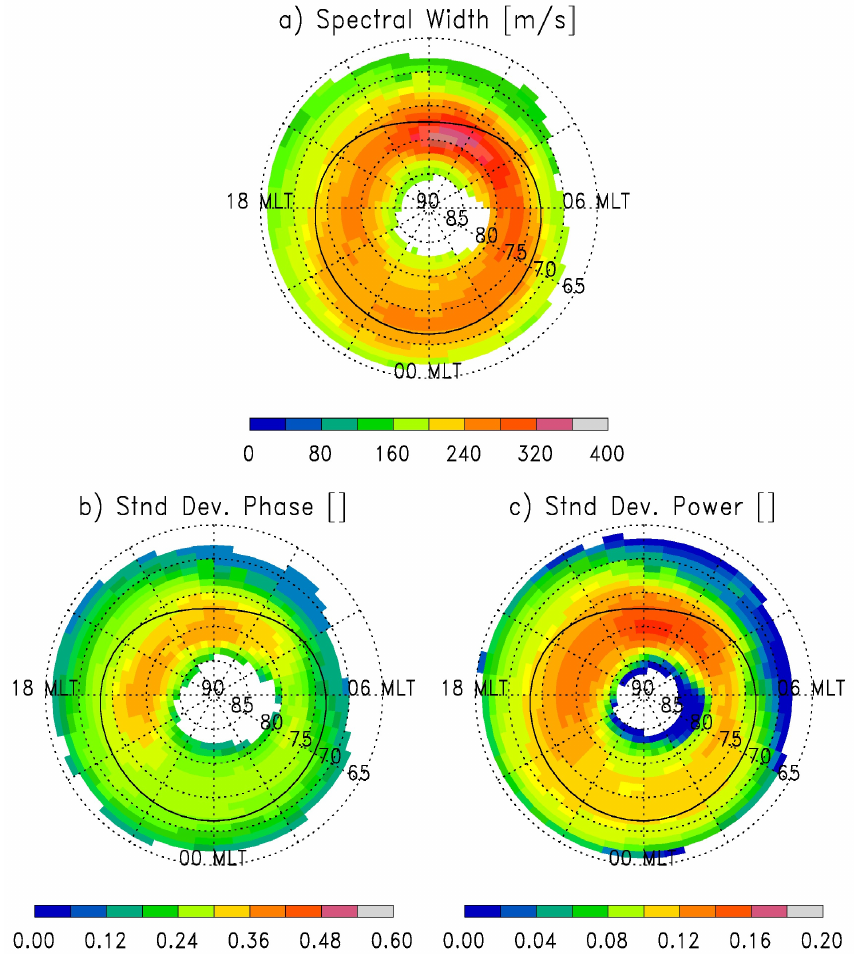
Fig. 2. Mean value of the (a) ACF spectral width, (b) errors on the fit performed on the ACF phase and (c) error on the fit performed on the ACF power. The black line represents the average position of the poleward boundary of the auroral oval as modelled by Holzworth and Meng (1975) for moderate magnetic activity.